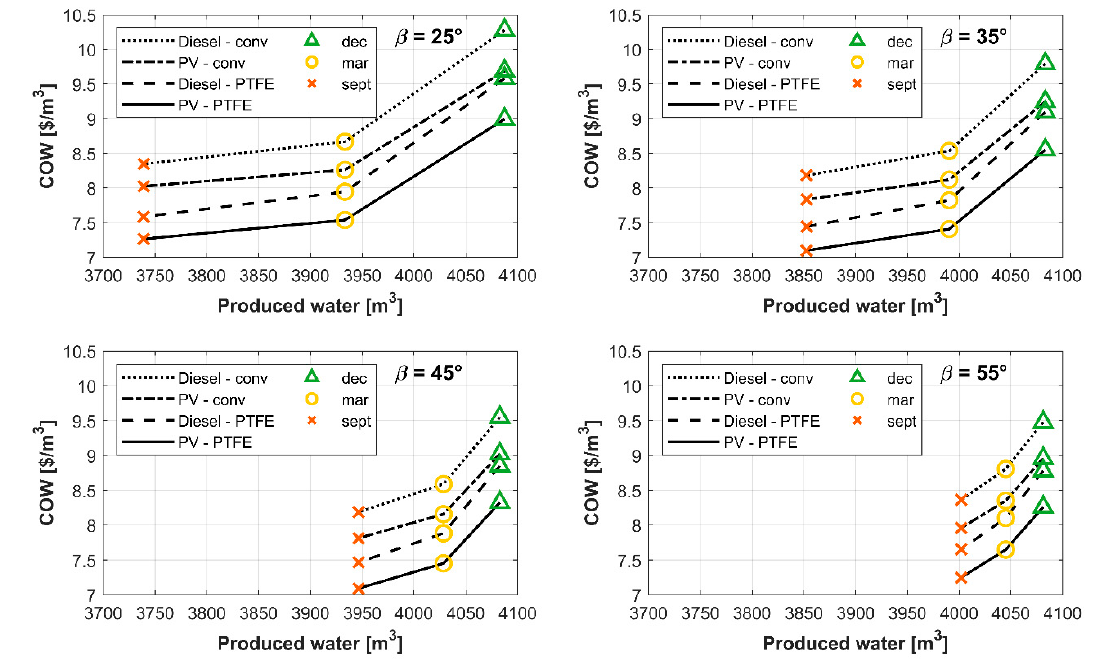
Figure 7. COW versus water production in the year at different design month and β with TBT = 50 °C for different exchangers (conv/PTFE) and a different electrical generation (PV/Diesel).